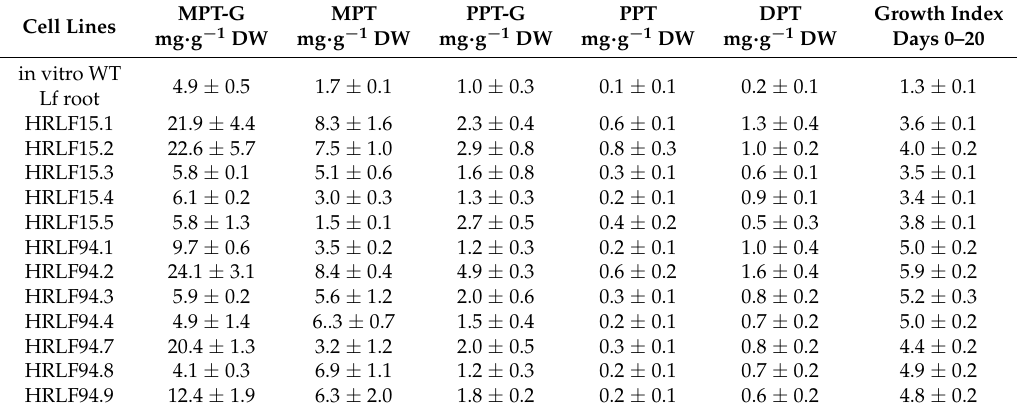
Table 1. Lignans profiling and growth index of wild type in vitro or transgenic hairy roots of L. flavum cultivated on hormone free B5-derived